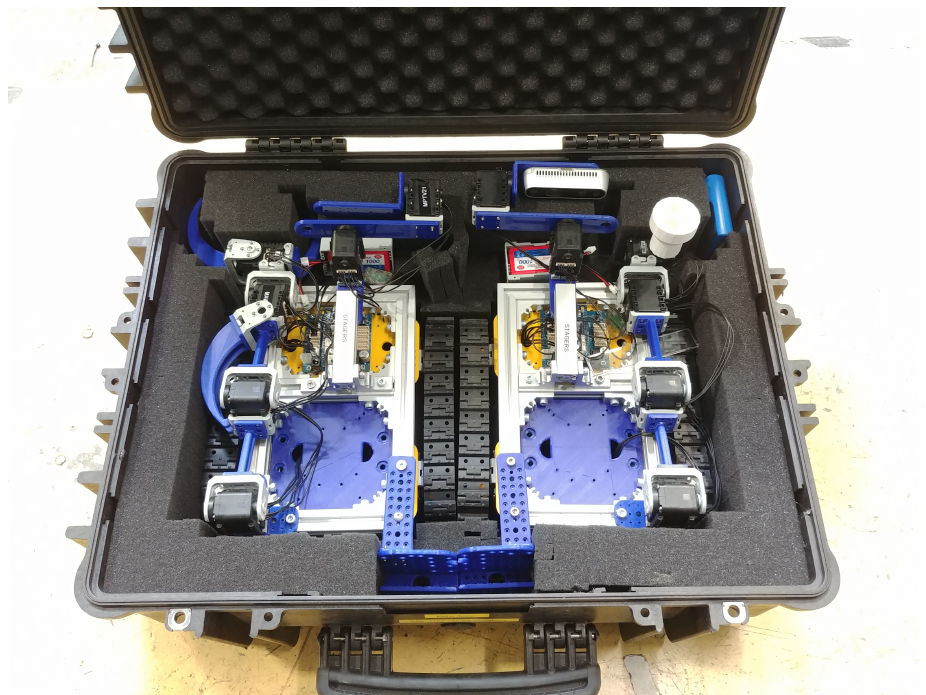
Figure 25. The MiniCernbot platforms in their storage